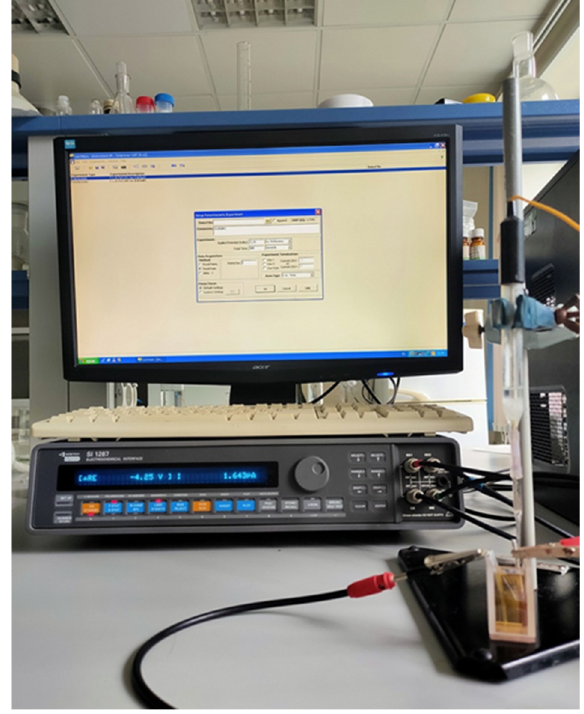
Figure 1. The equipment for the electrochemical syntheses.